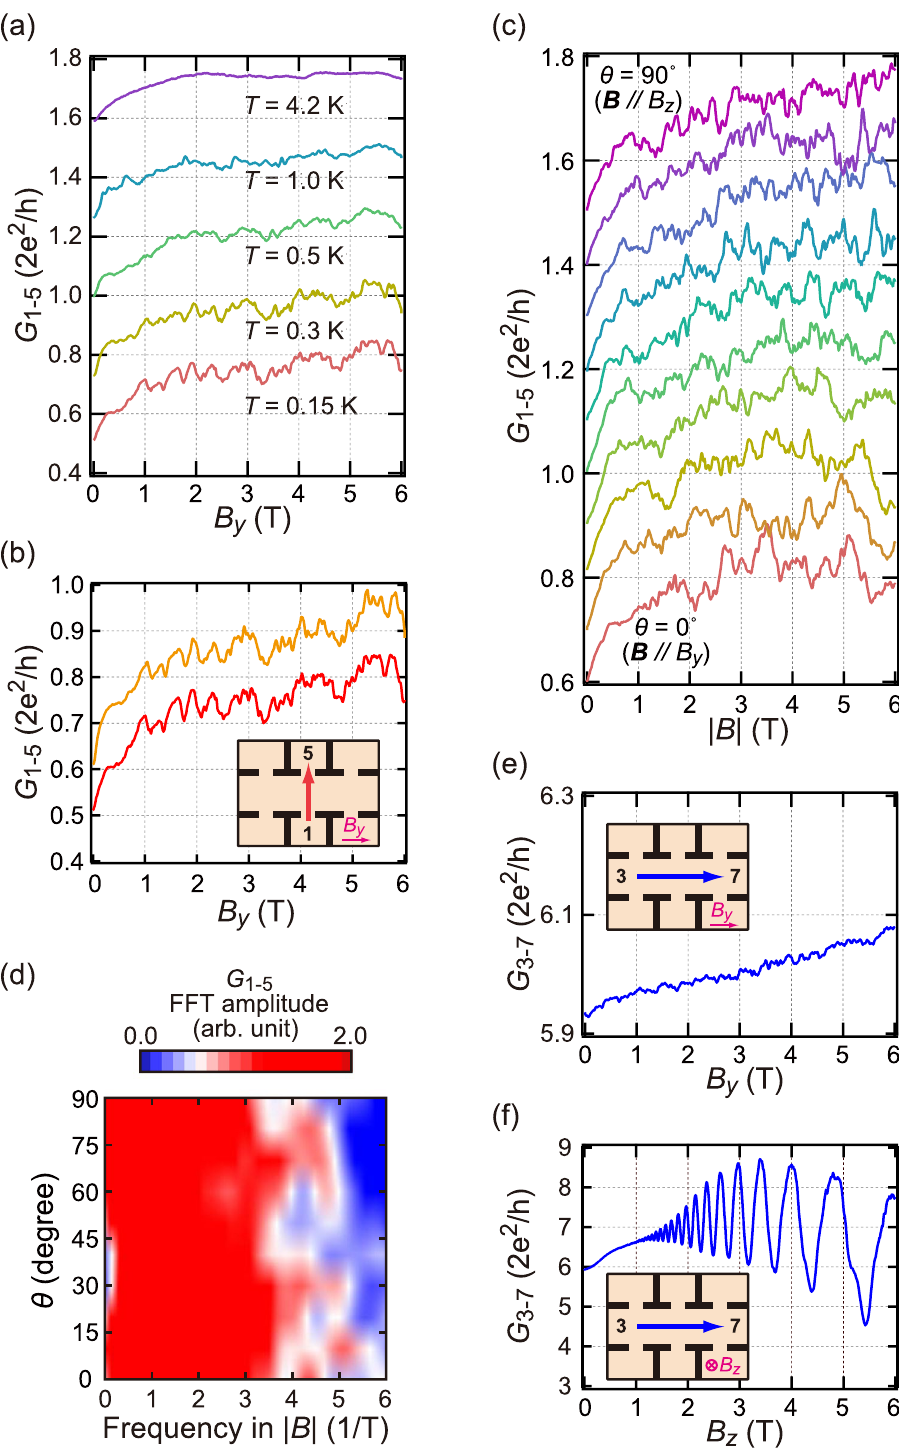
Figure 3. Reproducible conductance fluctuation versus magnetic field. ( a ) G 1–5 as a function of B y for different temperatures with offset 0.2 G q . ( b ) G 1–5 for two individual magnetic sweeps with offset 0.1 G q . The inset shows the terminal configuration. ( c ) G 1–5 at 70 mK versus field amplitude | B |. The direction of the magnetic field (the zenith angle θ ) is rotated from θ = 0 to 90° at azimuth angle ϕ = 90°. The steps in the angle and conductance offsets are 10° and 0.2 G q , respectively. ( d ) 2D plot of the FFT amplitude spectrum of the conductance fluctuation versus | B | from 1.5 to 6 T and θ . ( e ) and ( f ) G 3–7 at 70 mK (see inset for the configuration) plotted against B y and B z ,